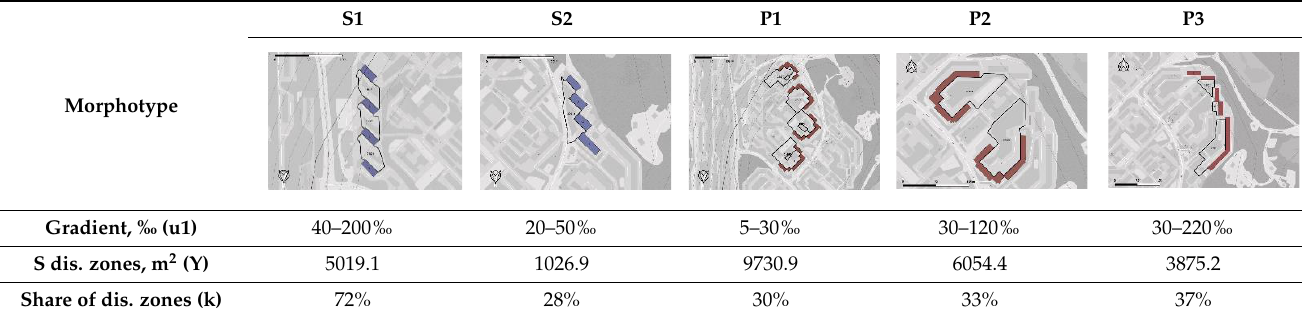
( b ) Figure 25. Petal diagrams showing the boundary of discomfort at gradients 52 – 190 ‰ and data on the share of discomfortable zones k: ( a ) perimeter morphotype, ( b ) ribbon morphotype. Figure 26 shows that the courtyard areas of all groups of houses are outside the boundaries of comfort, and group S1 has a very large share of discomfortable zones ac- cording to the results of the theoretical study. To correct, or to reduce, the share of dis- comfortable zones, it is necessary to apply methods of improving aeration comfort by tak- ing actions aimed at protecting these areas from wind.